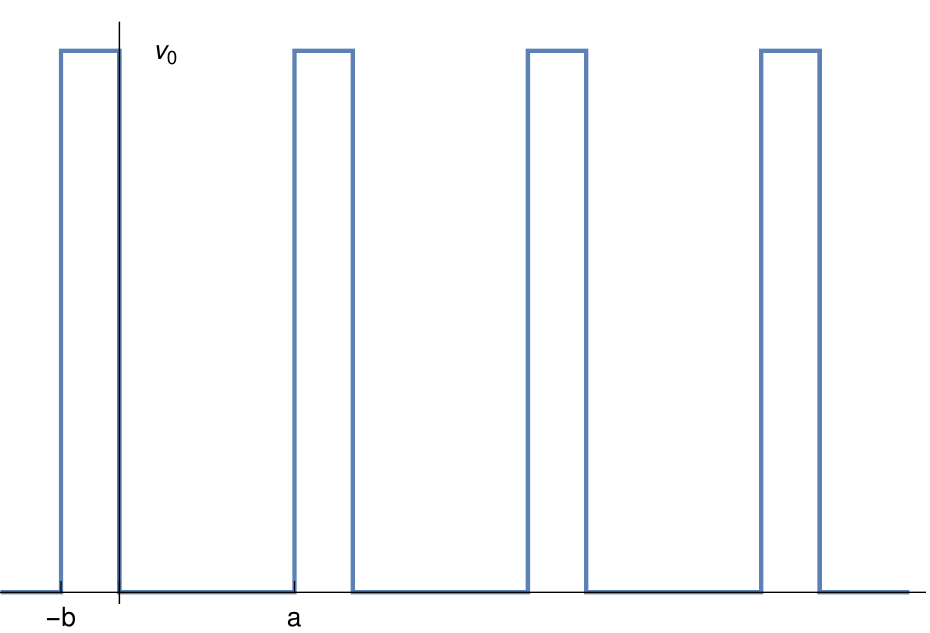
Figure 1. The potential in the model of Kronig and Penney [2]. In this paper, we consider the case b → 0, v 0 → ∞ , such that b v 0 = Ω